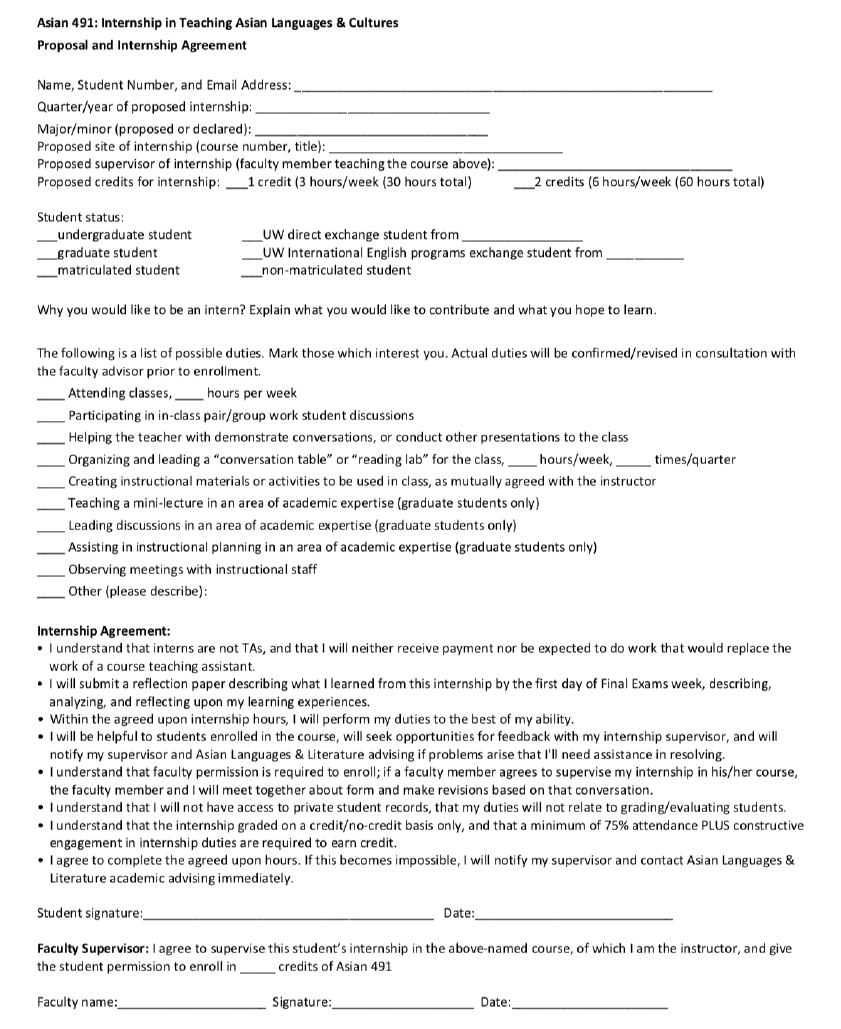
Figure 5. Proposal and Internship Agreement for Internship in Teaching Asian Languages and